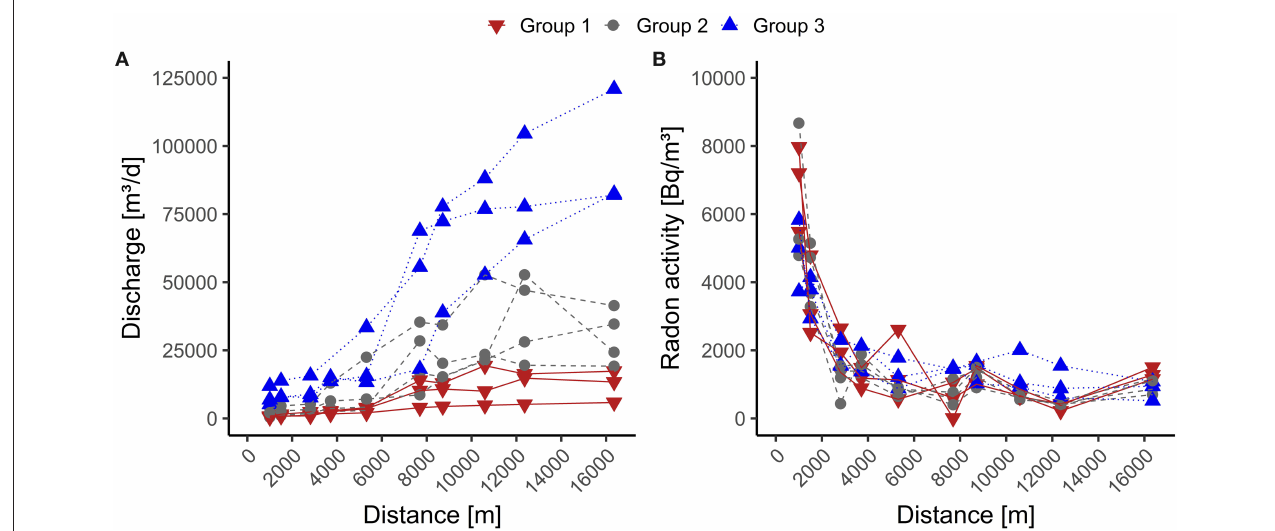
FIGURE 3 | Radon activity and discharge along the stream, separated by group 1 (discharge below average low water discharge), group 2 (discharge between average low water discharge and average discharge), and group 3 (discharge above-average discharge. (A) shows the change of discharge along the stream. (B) illustrate the change of 222 Rn activity along the stream.